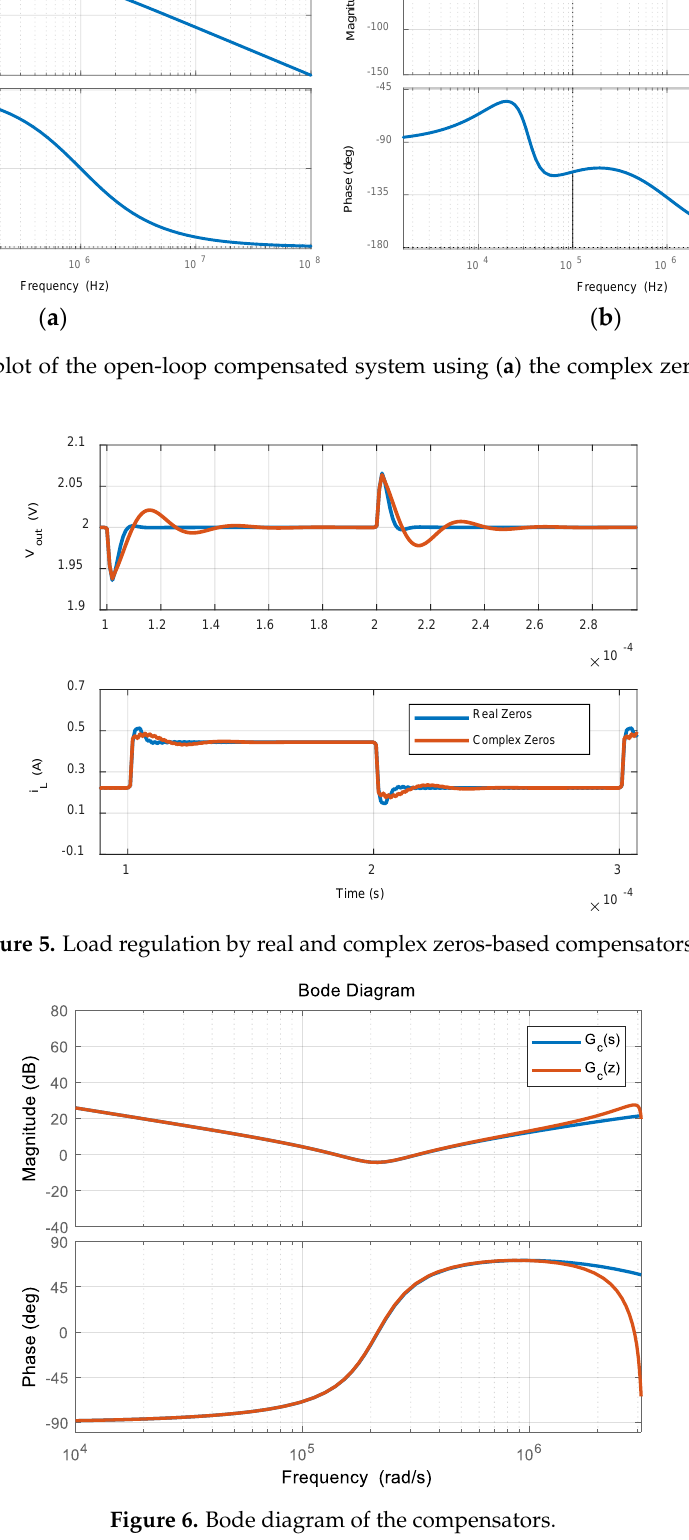
Figure 6. Bode diagram of the compensators.